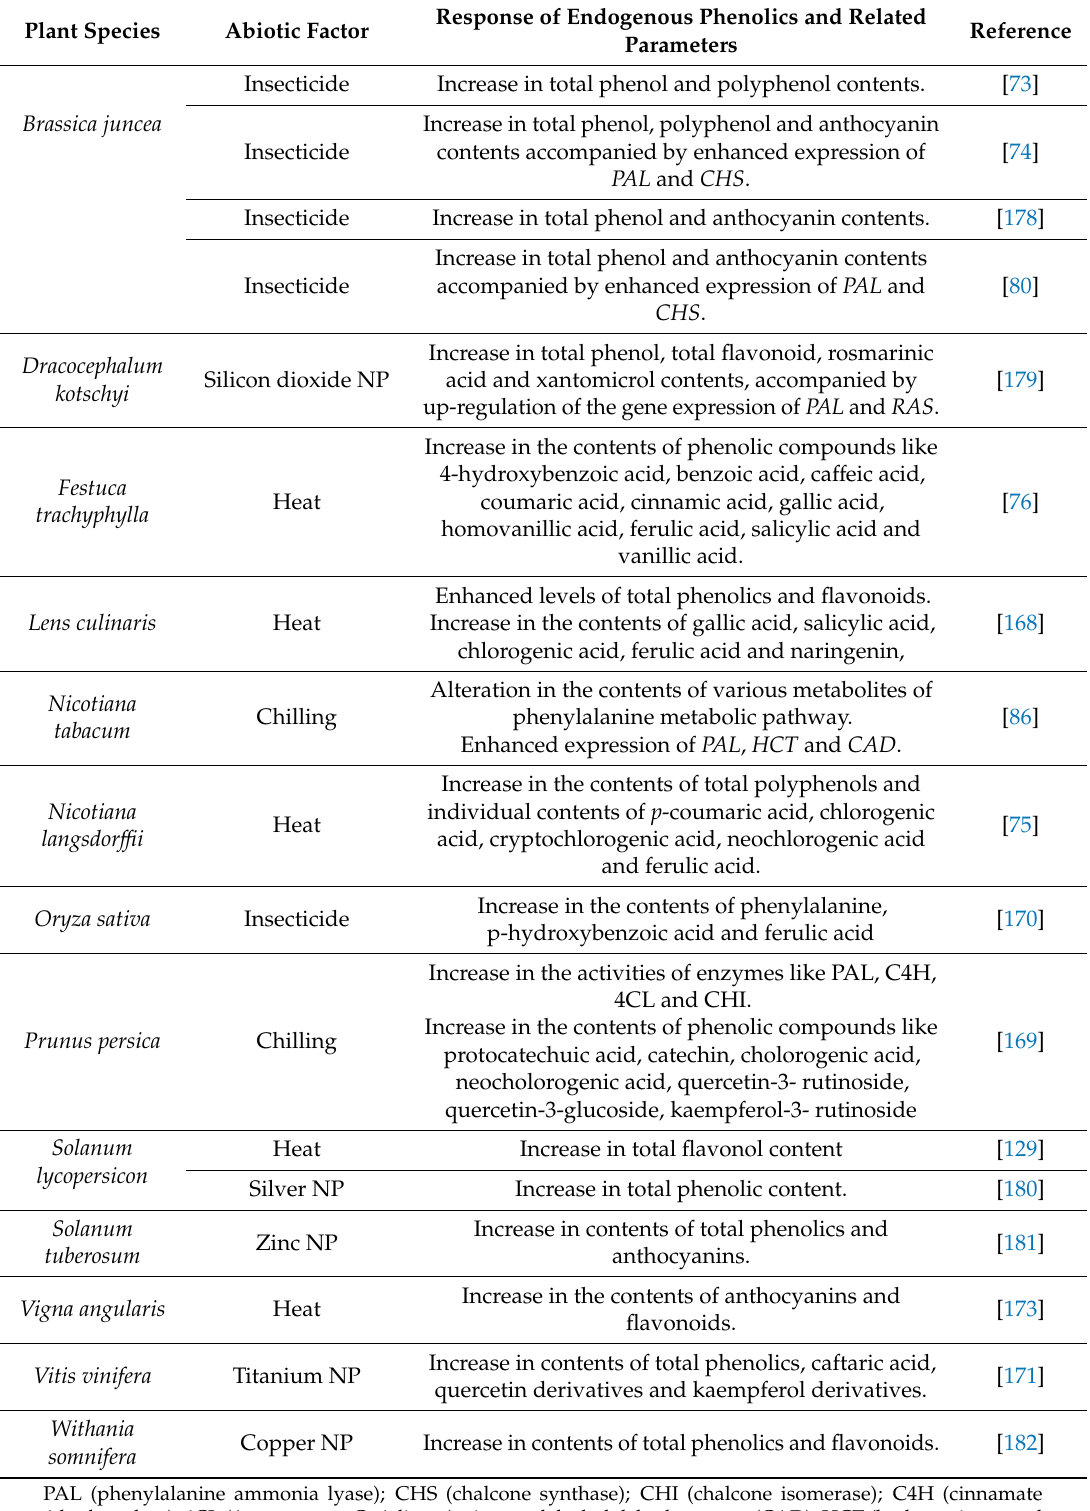
Table 5. Summary table describing the impact of various abiotic factors on the endogenous levels of various phenolic compounds in